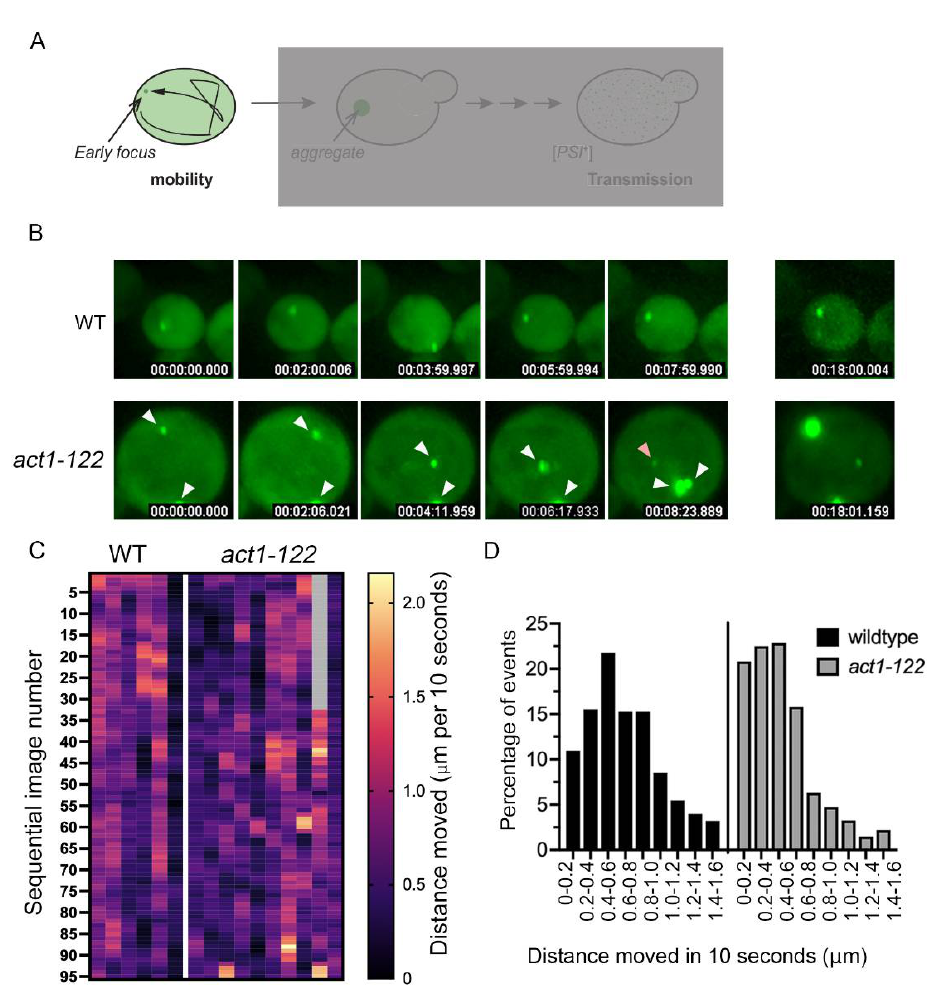
Figure 2. Multiple early foci form in act1-122 mutants and appear to be generally less mobile. ( A ) Top, model showing the multiple steps of [ PSI + ] formation analyzed in this paper and highlighting the early foci step analyzed in this figure. ( B ) Sup35NM-GFP was expressed for 16–24 h with copper, with the indicated strains transferred into deep well slides containing fresh media without copper. Cells with early foci were imaged every 10 s in three dimensions. White arrows indicate multiple foci and pink arrow indicates a newly appearing focus. Images are maximum projections of 3D images. ( C ) By plotting 3D coordinates of foci within each image, the distance moved ( µ m per 10 s) is plotted on the heat map. Each column represents the distance moved of an individual focus (even if there are multiple aggregates per cell, as indicated by arrows in ( B )). The second column from the last in the act1-122 heatmap corresponds to a new focus indicated by the pink arrow in ( B ) above, such that the first 30+ timepoints are indicated as no data. ( D ) The distance traveled (per 10 s) distribution for early foci movement is shown in wildtype ( left ) or act1-122 ( right ) strains. The run length, or cumulative distance traveled in 10 s, was compiled for all early foci in the indicated strains. Histograms show the distribution of run lengths vs. the percentage of times that length was